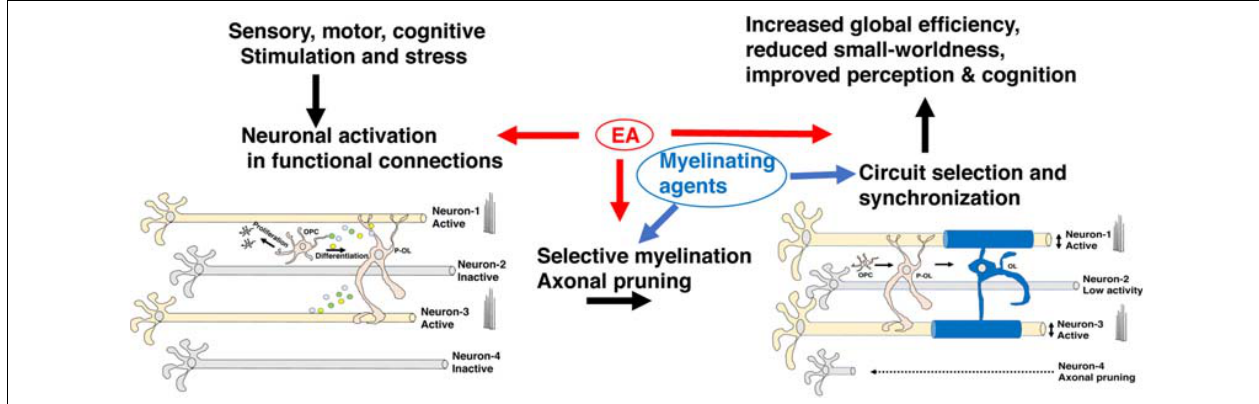
FIGURE 5 | Myelin promotes the selection of functional circuits during development. Environmental stimulation or deprivation early in life leads to changes in neuronal activity in the developing brain. Increased activation in appropriately connected functional units (neurons 1 & 3) but not in neurons 2 & 4 leads to preferential myelination, enhanced metabolic support, and axonal growth in neurons 1 & 3 at the expense of neuron 2. Neuron 4 undergoes axonal pruning commonly seen during a critical period of transcallosal-projection development and is irreversible later in life. Adaptive myelination coupled with axonal pruning promotes synchronization of functional circuits and maturation of network properties (e.g., increased global efficiency and reduced small-worldness) that improve cognition and perceptual accuracy. Exposure to EA interferes with different aspects of this process and can potentially be reversed by myelinating agents. EA, early adversity; OL, mature oligodendrocyte; OPC, oligodendrocyte progenitor cell; P-OL, pre-myelinating oligodendrocytes.